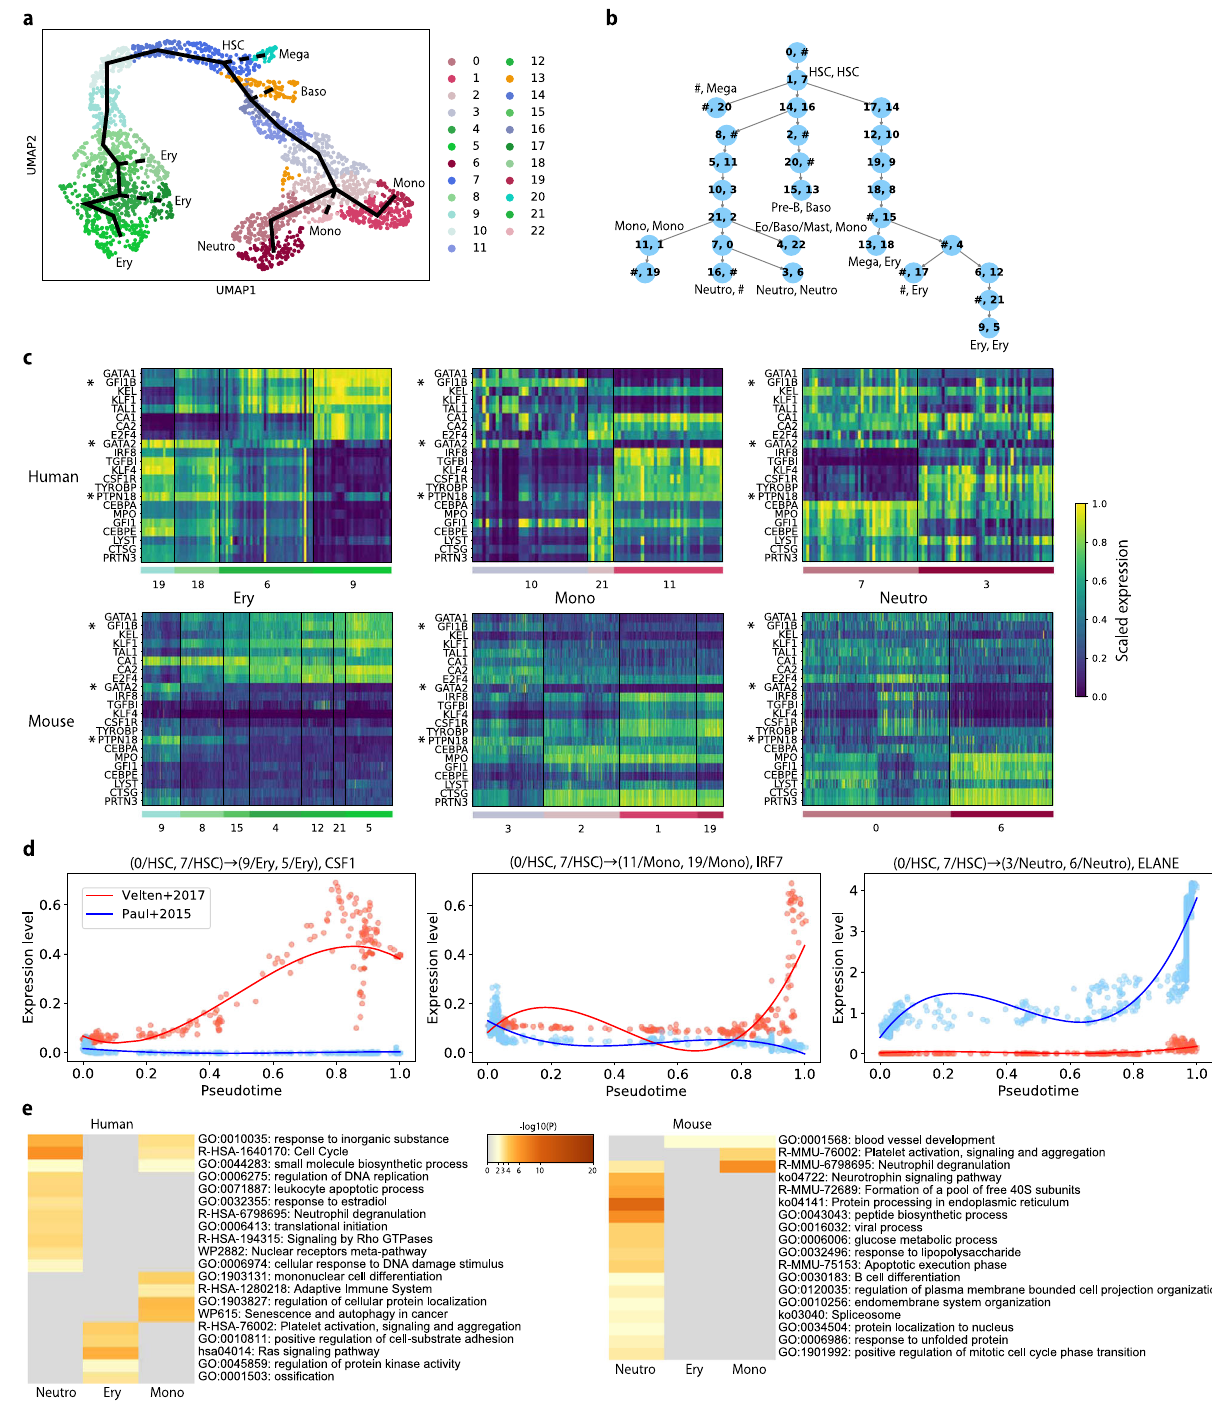
Fig. 6 | Application of CAPITAL to cross-species scRNA-seq datasets of bone marrow cells. a A UMAP plot of clustering results along with a trajectory inferred by CAPITAL for Paul et al.'s data. An estimated trajectory is shown by a thick black line,wherethesolidlinesindicatethelineartrajectoriesthatarecomparedin( c – e ), whereas the dashed lines represent the others. b An alignment of the trajectory trees, where each pair of numbers in a node denotes the clusters shown in Fig. 5b and this fi gure ( a ). # denotes a space. c Heatmaps of known cell-type markers for erythrocyte, monocyte, and neutrophil with similar expression patterns in the datasets.Theseareorderedbypseudotimefromlefttorightineachheatmap.Note that the markers in mouse are orthologous to the ones in human, and for clarity, these names in mouse are exactly the same as those in the human dataset. A gene